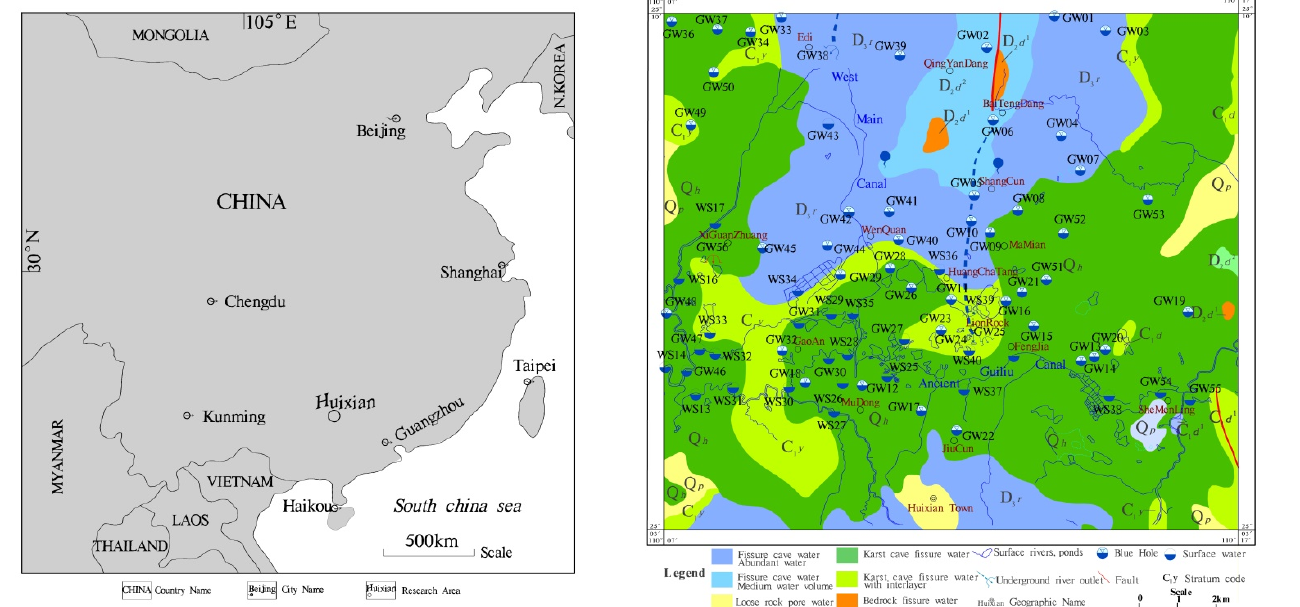
Figure 1. Location of the Huixian wetland and distribution of sampling sites.